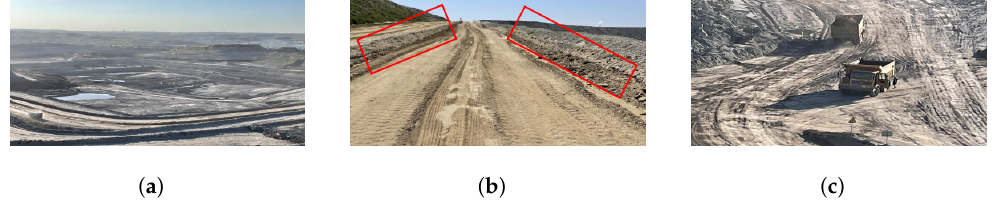
Figure 1. Illustration of a mining environment. ( a ) Mining environment. ( b ) Road boundary. ( c ) Bumpy road.